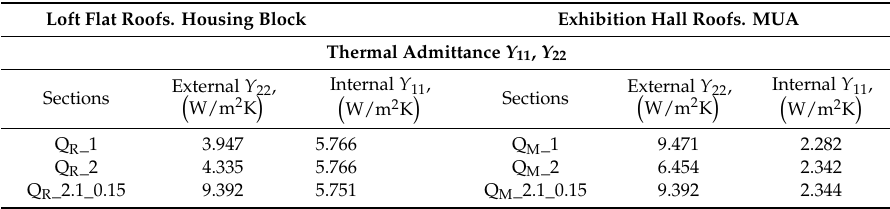
Table 14. Internal and external thermal admittance values.